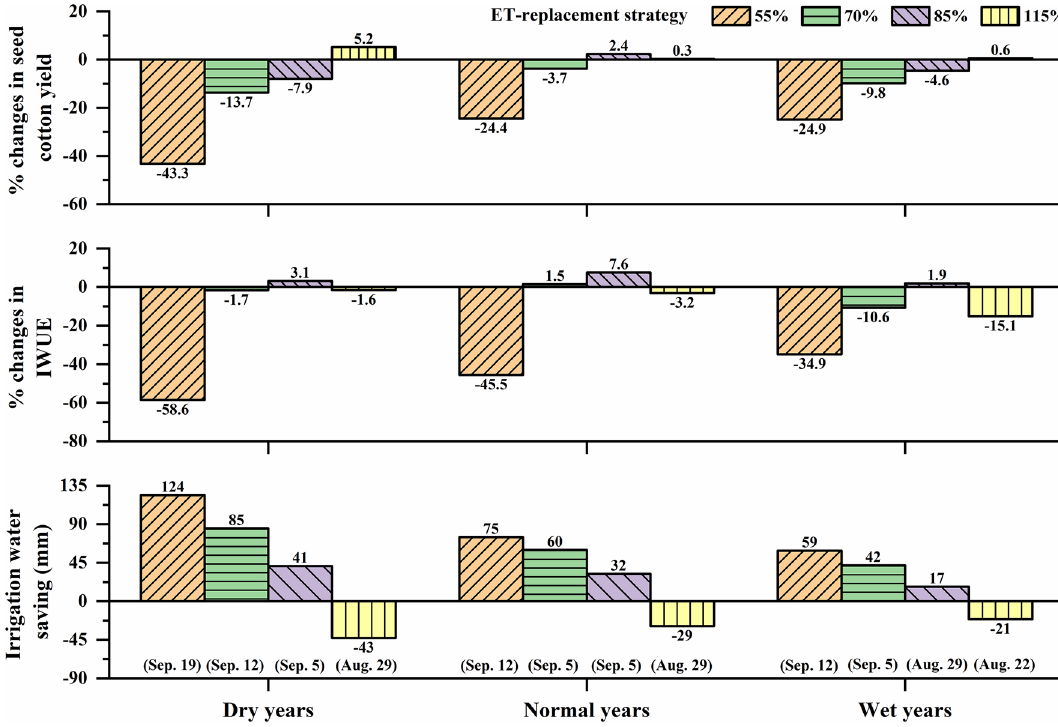
Figure 5. Effects of irrigation termination periods on percent changes [increase (+)/decrease (−)] in seed cotton yield (top panel) and IWUE (center panel), and differences in the amount of irrigation water (bottom panel) under different ET-based irrigation strategies (55%, 70%, 85% and 115% ET replacement) as compared to 100% ET-replacement irrigation strategies. The suggested irrigation termination periods under different ET-based irrigation strategies are shown in parentheses at the bottom of respective